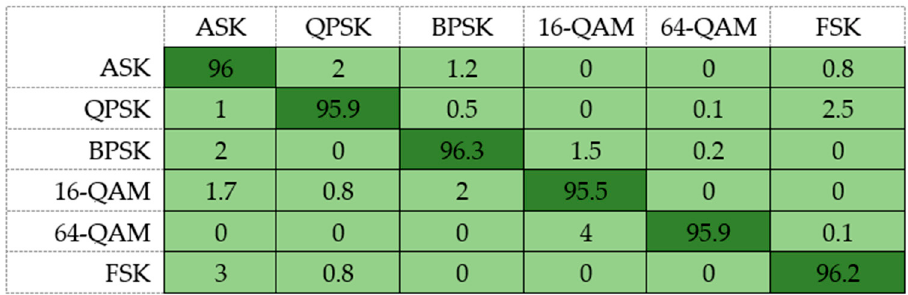
Figure 12. Confusion matrix for the proposed AMC2N.